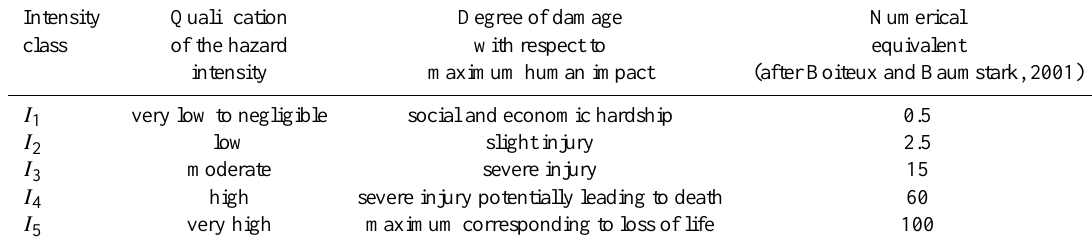
Table 2. Intensity baseline for all adverse events related to human life (adapted from Stieltjes, 1997). Intensity Qualification